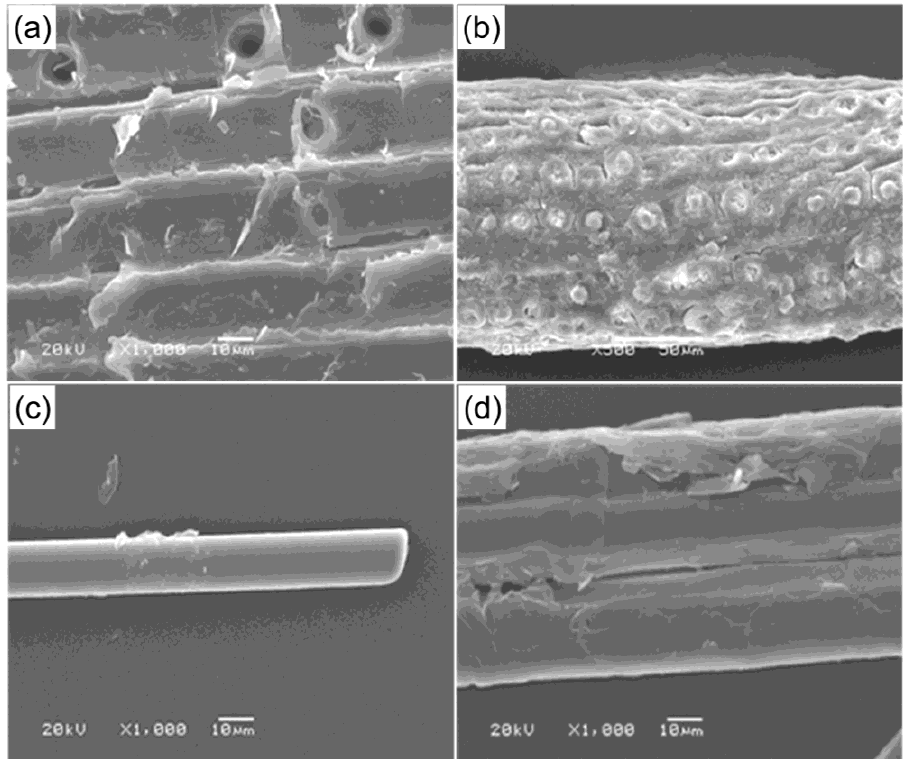
Figure 1. Scanning electron microscopy (SEM) images of surface of natural fibers: ( a ) wood flour, ( b ) coconut shell, ( c ) basalt fiber, ( d ) flax